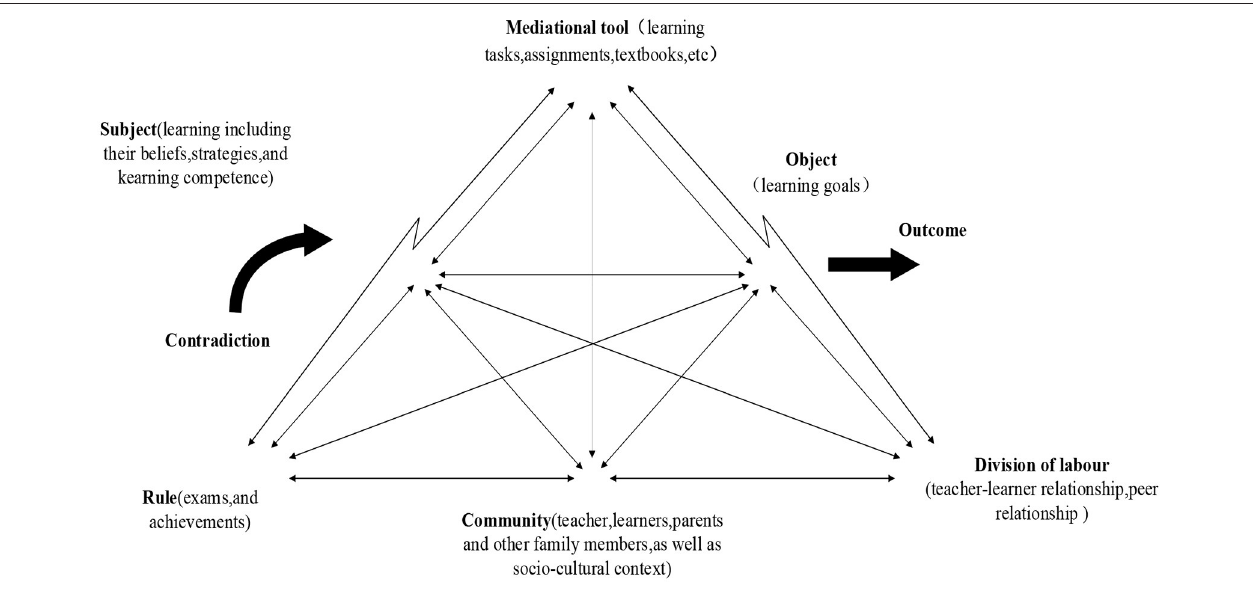
FIGURE 2 | Demotivators from the activity theory